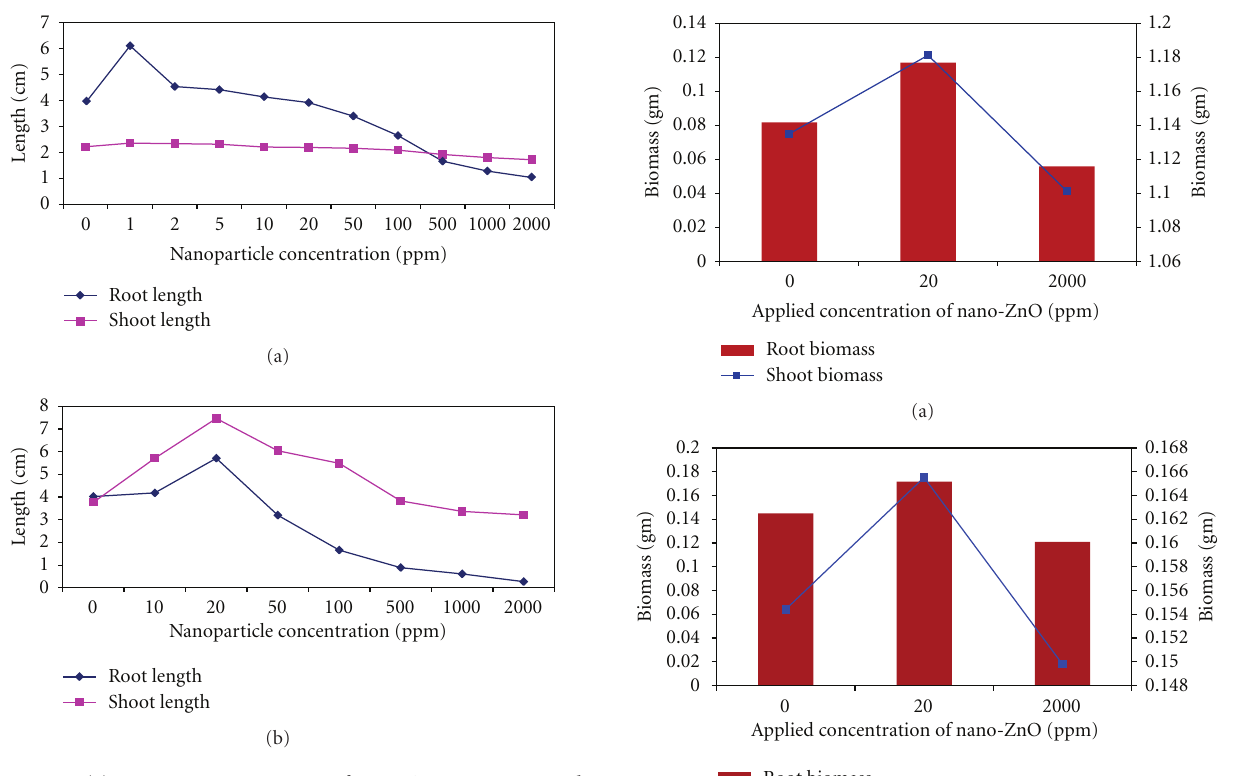
Figure 2: (a) Dose-response curves of nano-ZnO on root and shoot of mung seedlings. The values were given as mean ± SD (standard deviation) of triplicate samples with 10 seeds each. (b) Dose response curves of nano-ZnO on root and shoot of gram seedlings. The values were given as mean ± SD (standard deviation) of triplicate samples with 10 seeds each.